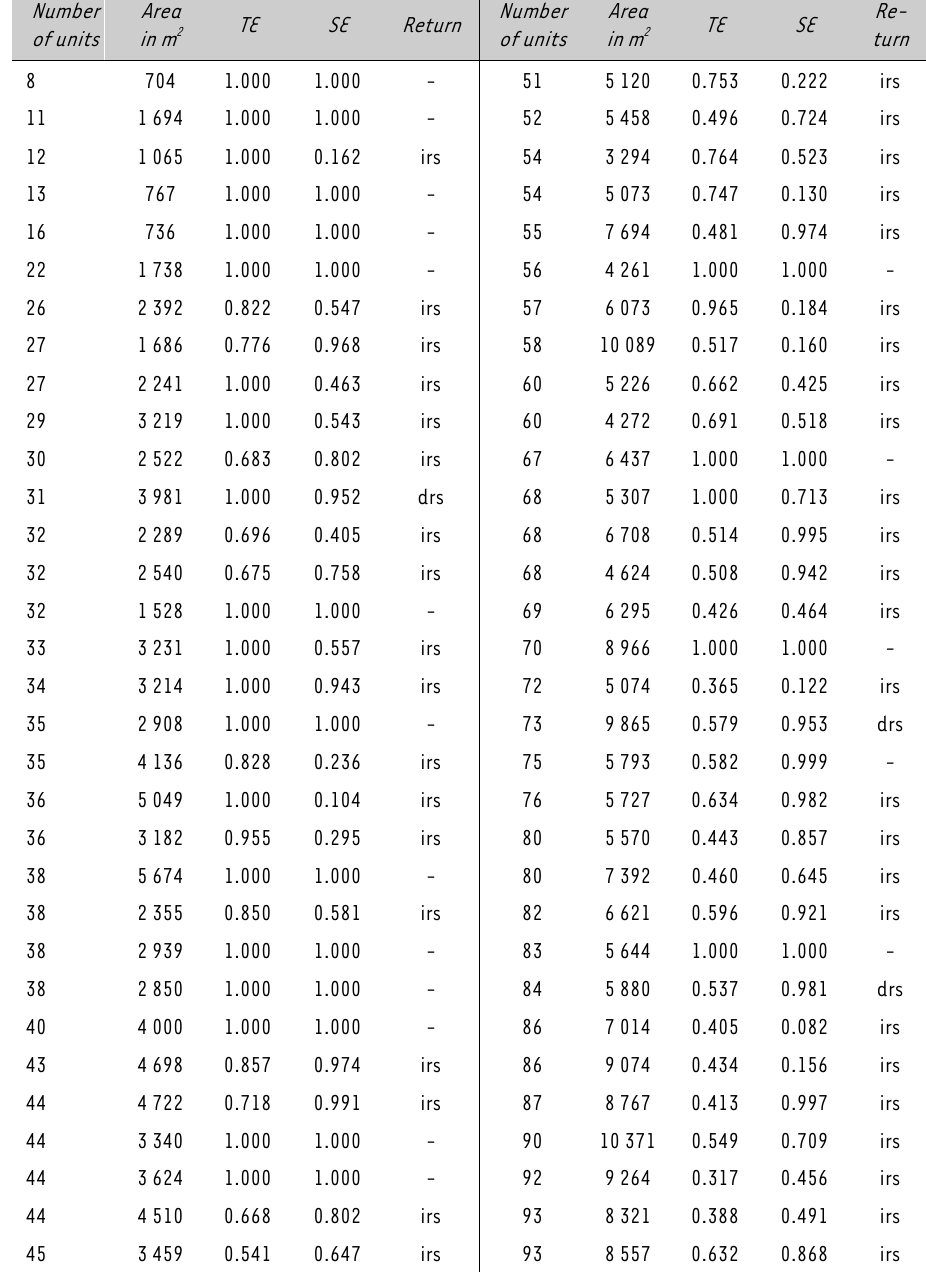
TABLE 3: Relative efficiency estimates for small STDSs (n =